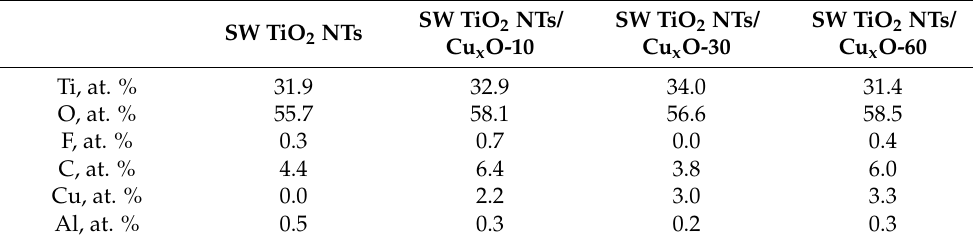
Table 1. EDX microanalysis data for SW TiO 2 NTs arrays with different copper content.